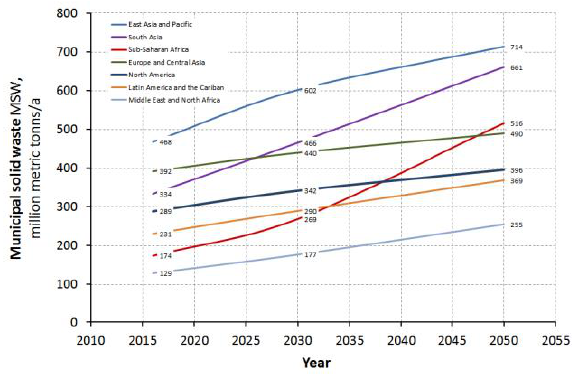
Fig. 2. Municipal waste now and in forecasts (data from